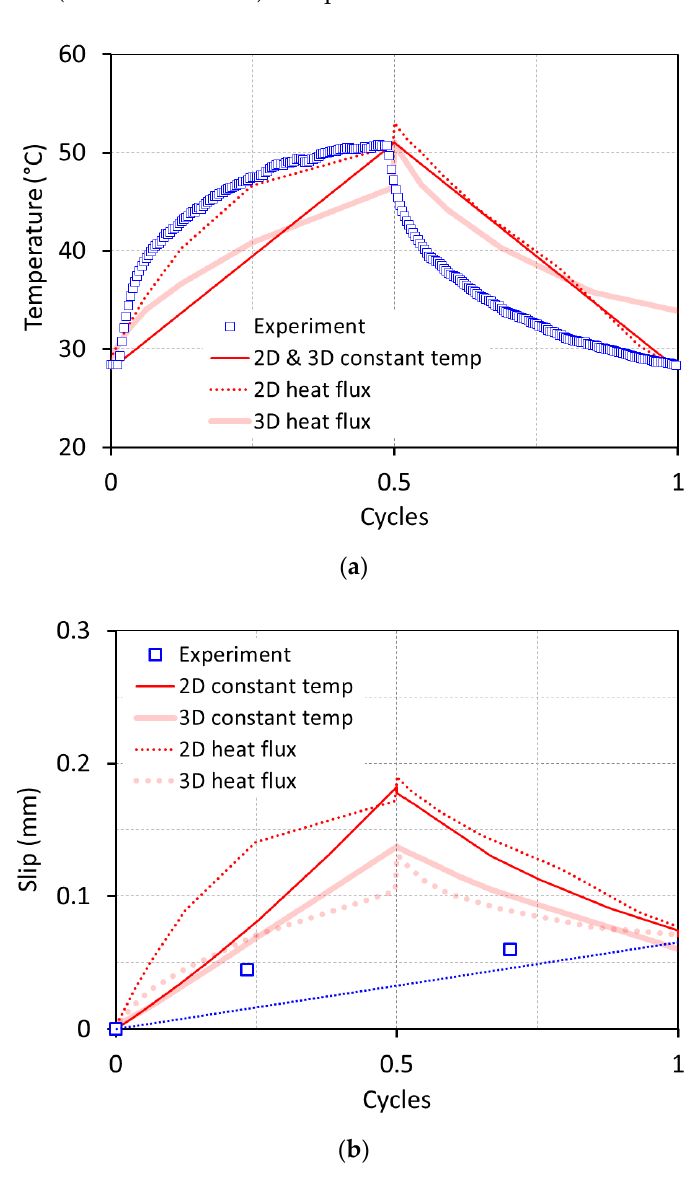
Figure 18. Effect of the transient heating condition on the residual slip. ( a ) Temperature change during the first heating– cooling cycle and ( b ) slip